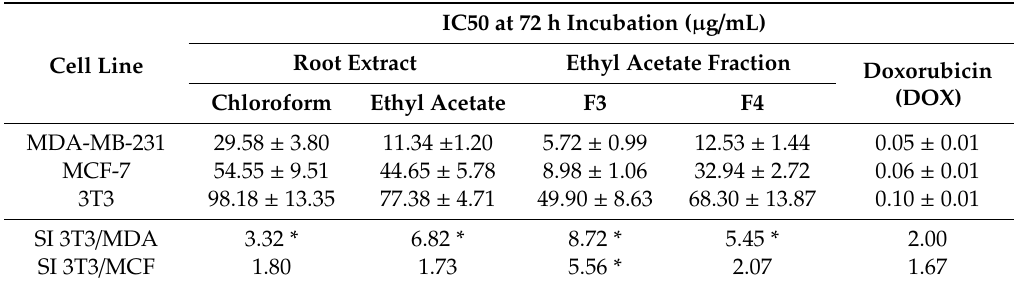
Table 1. Selectivity index of the most active and second active extract and fraction of C. vespertilionis in comparison to drug control doxorubicin against breast cancer cell lines based on the IC 50 values.